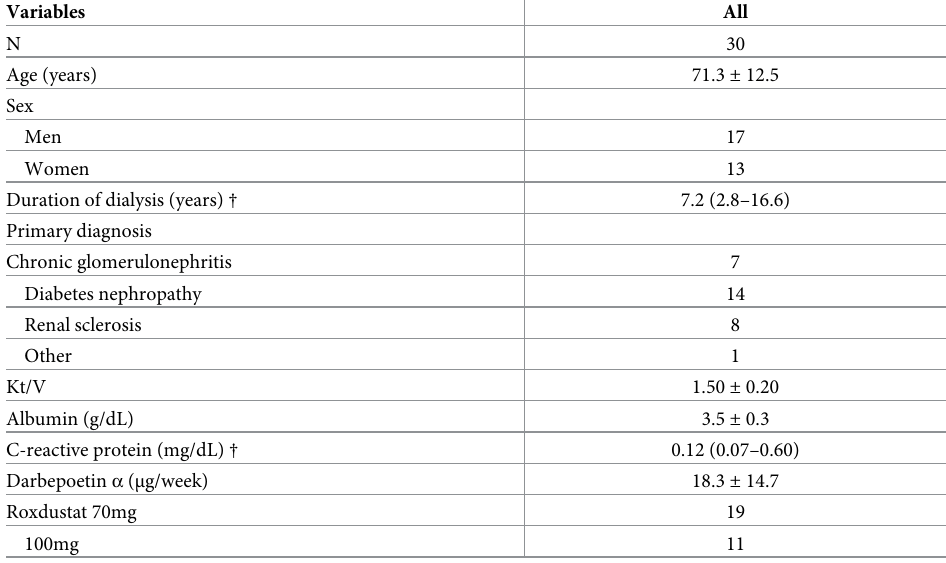
Table 1. Patient